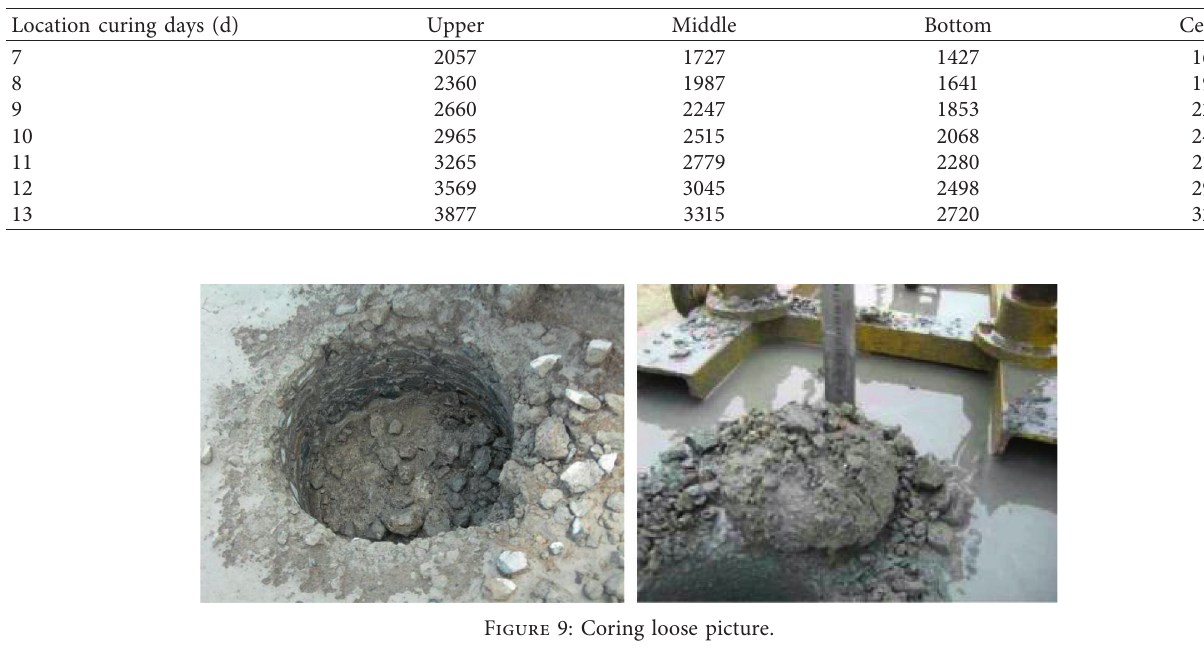
Table 3: The “Temperature × Time” data for each position ( ° C · h).